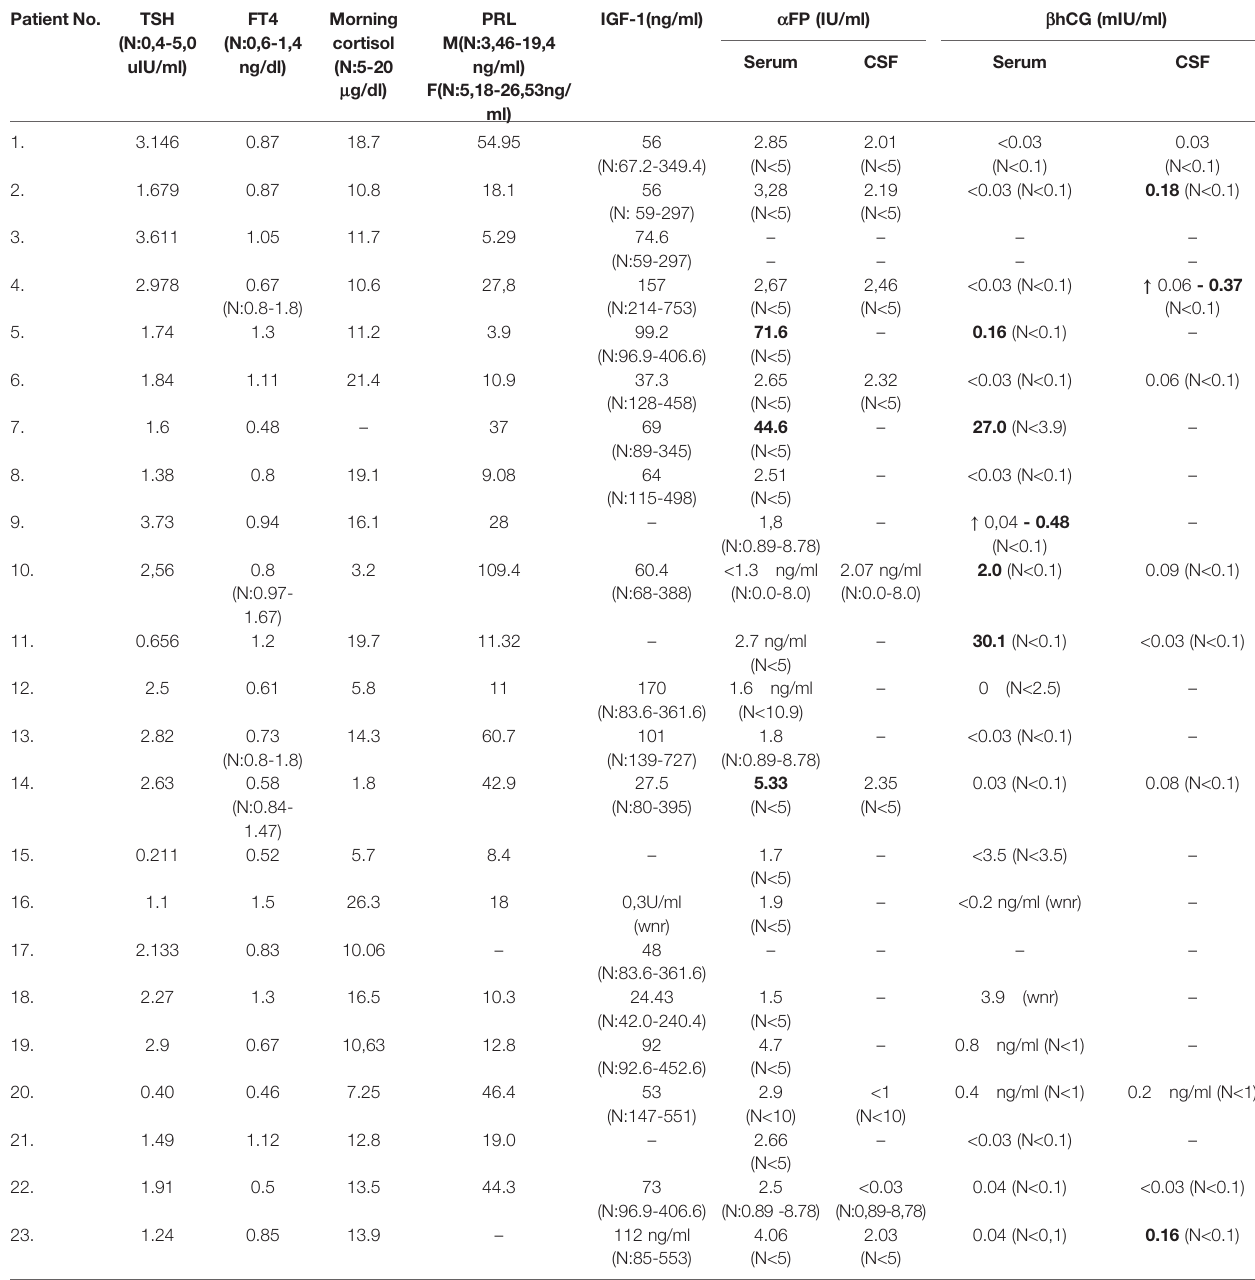
TABLE 2 | Hormonal and other evaluations. Patient